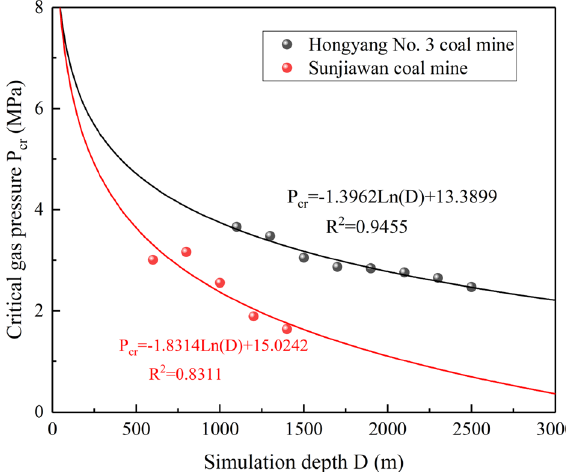
Figure 7. Comparative analysis of critical gas pressure for